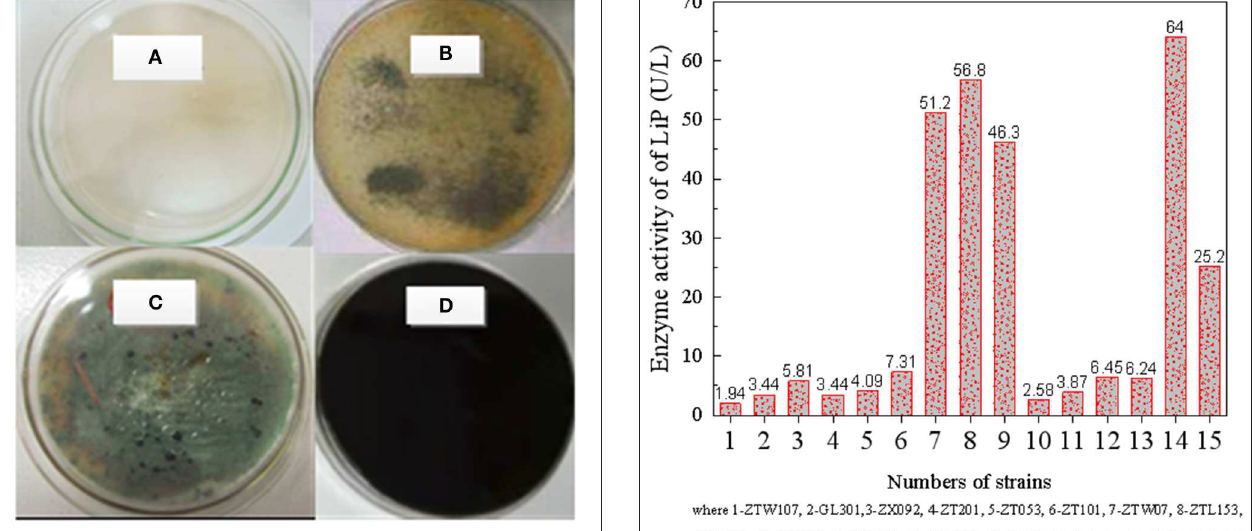
FIGURE 1 | Effect of White Rot Fungi on Liquefaction of Zhaotong Lignite. (A) Strains + DOX culture; (B) Zhaotong lignite + DOX culture; (C) strains + DOX culture + Zhaotong lignite (upper side); (D) strains + DOX culture + Zhaotong lignite (back side).